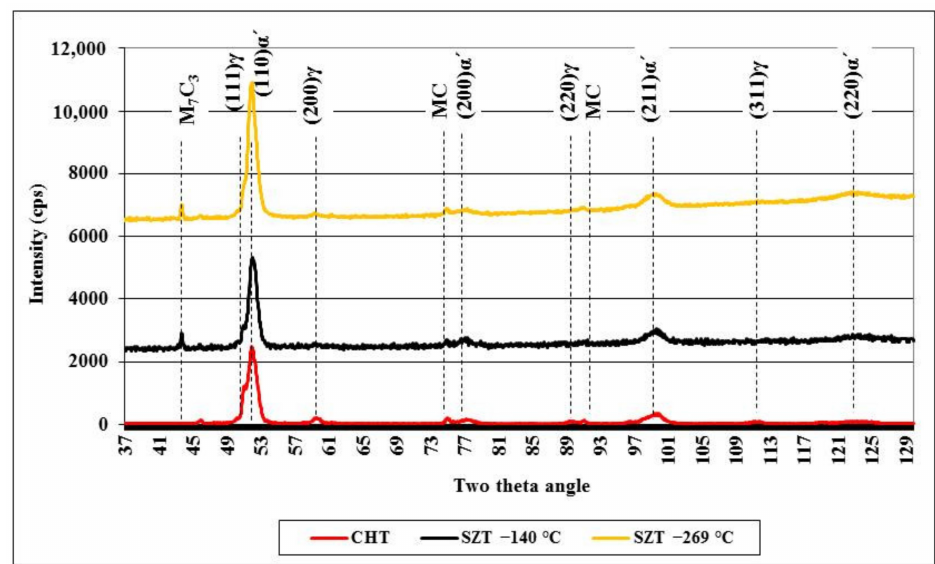
Figure 5. X-ray diffraction spectra of CHT steel and steel after SZT at − 140 and − 269 ◦ C.